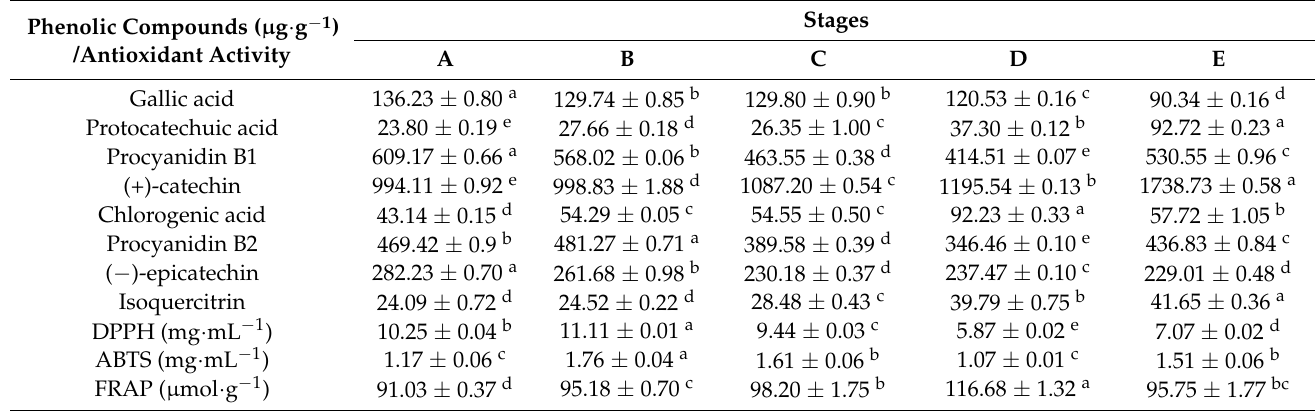
Values are means ± standard deviation ( n = 3). Different letters in the same row indicate significant differences ( p <